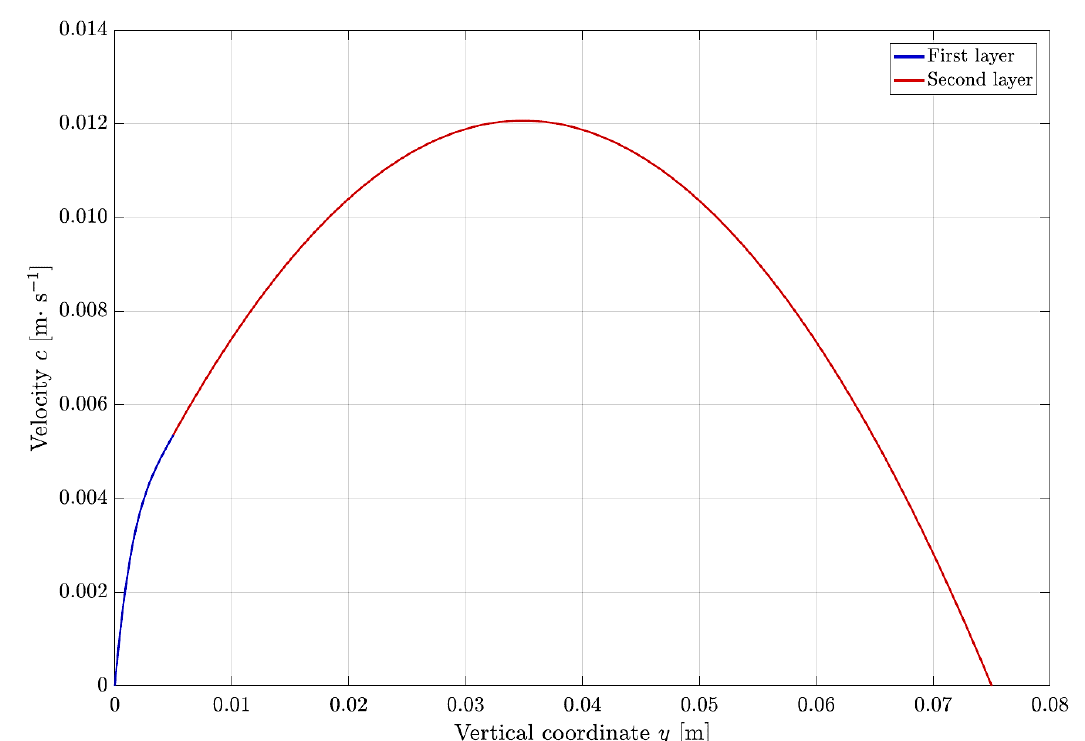
Fig. 1. Velocity profile